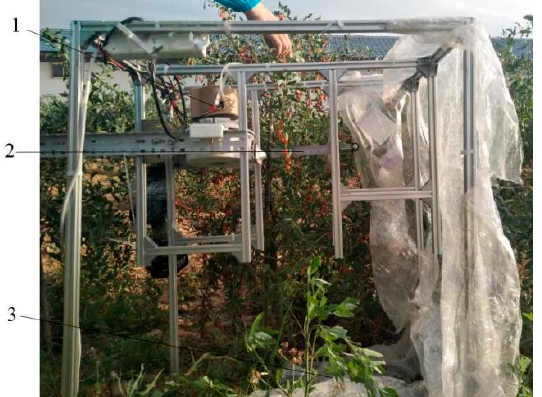
Figure 7. Chinese wolfberry harvesting performance test: 1. Chinese wolfberry harvesting test platform. 2. electronic angle ruler. 3. fruit collection cloth.